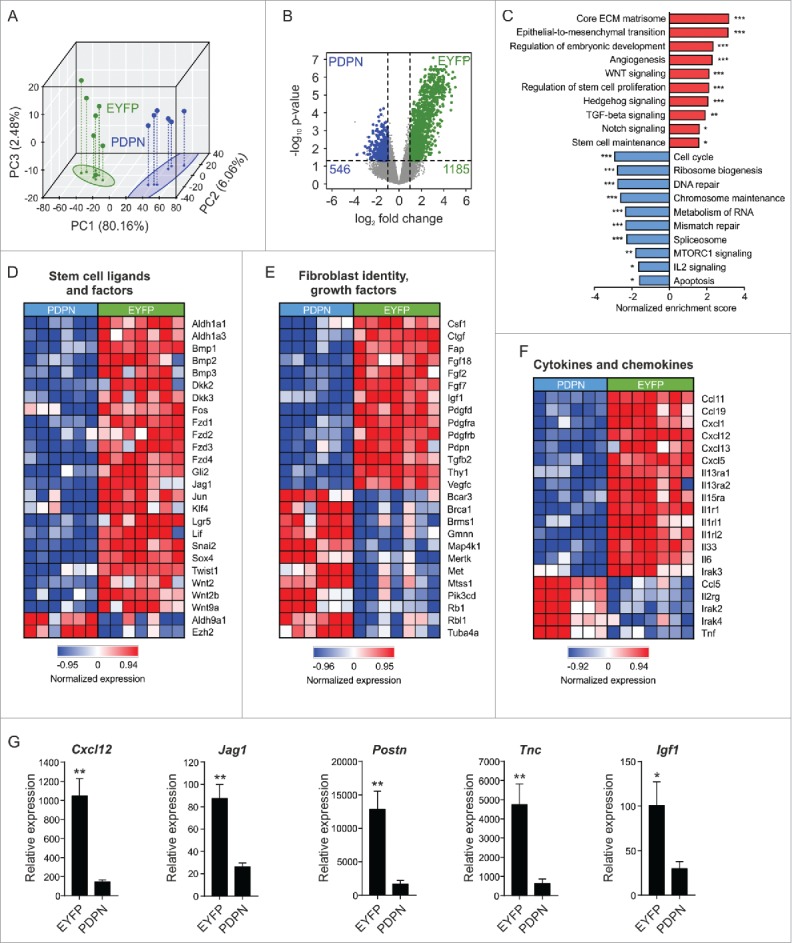
Oncogenic signature and stem cell factor expression by Il7-producing fibroblasts. Unilateral E0771 tumors were induced in Il7-EYFP mice and EYFP+PDPN+ (‘EYFP’) and EYFP−PDPN+ (‘PDPN’) CAFs were sorted from day 14–16 tumors. Samples were processed and microarray analysis was conducted. (A) 3D PCA of EYFP+ (n = 7) and PDPN+ (n = 6) breast CAFs. (B) Volcano plot analysis indicating differential expression of 1731 genes. (C) Functional pathway analysis by GSEA. (D-F) Heatmap analysis indicating upregulation of various growth- and stem cell factors as well as cytokines and chemokines by EYFP+ CAFs. (G) RT-PCR-based validation of microarray data for the indicated genes (n = 7–8). Statistical testing used: Mann-Whitney U test for panel G (for statistical details on panels A-F see Microarray analysis) (*p < 0.05, **p < 0.01, ***p < 0.001).